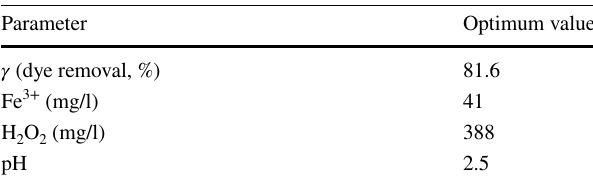
Table 6 Optimum values of the process parameters for